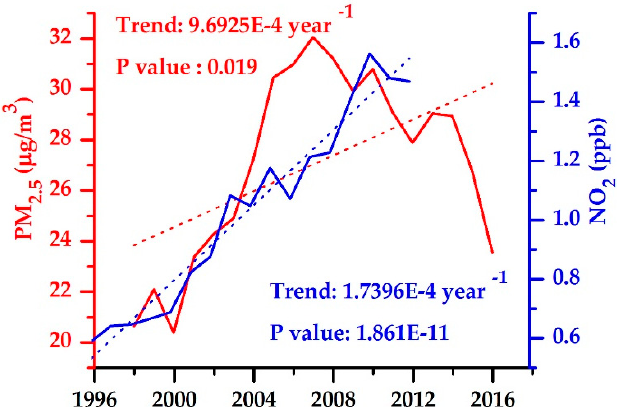
Figure 3. Trend analysis of annual mean near-surface PM 2.5 (1998–2016) and NO 2 (1996–2012) over the whole YRB.